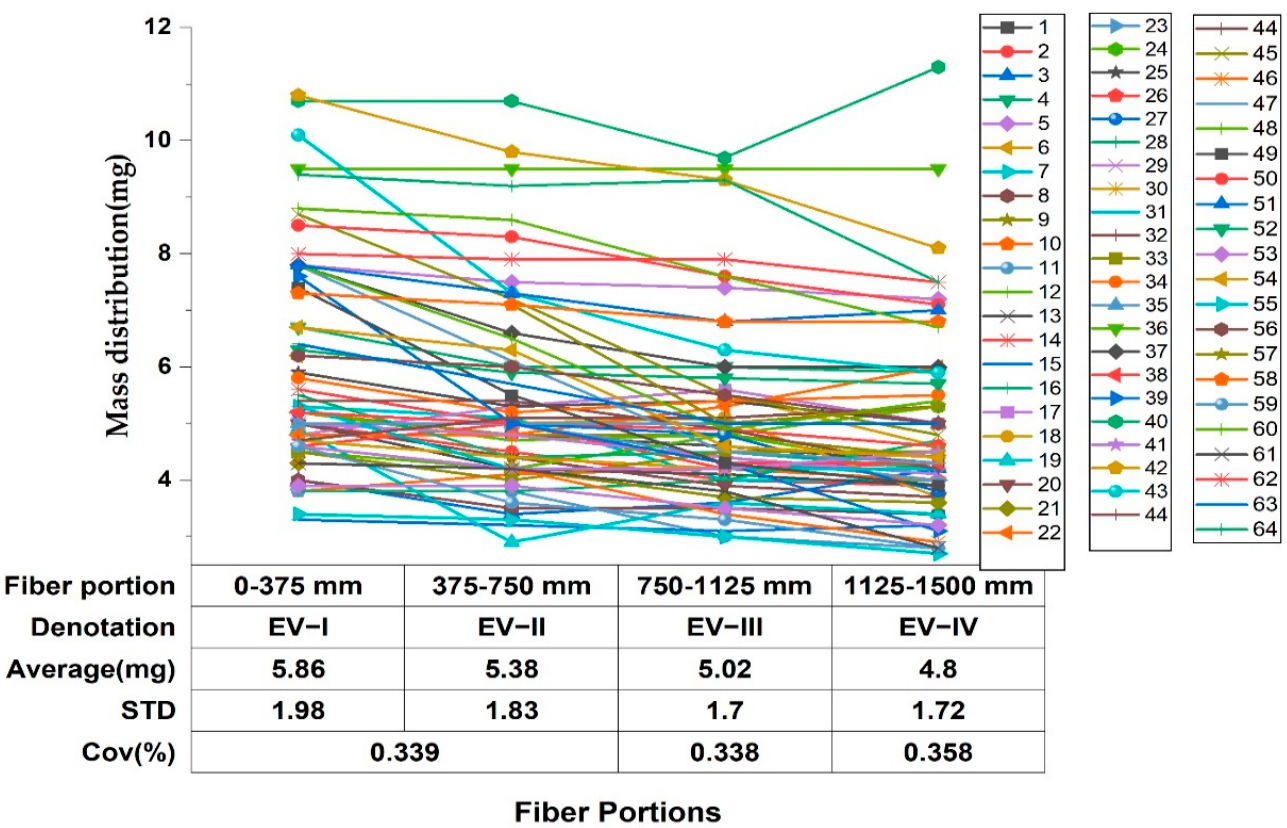
Table 1. The physical properties of Enset fiber (mean value ± standard deviation (STD)).